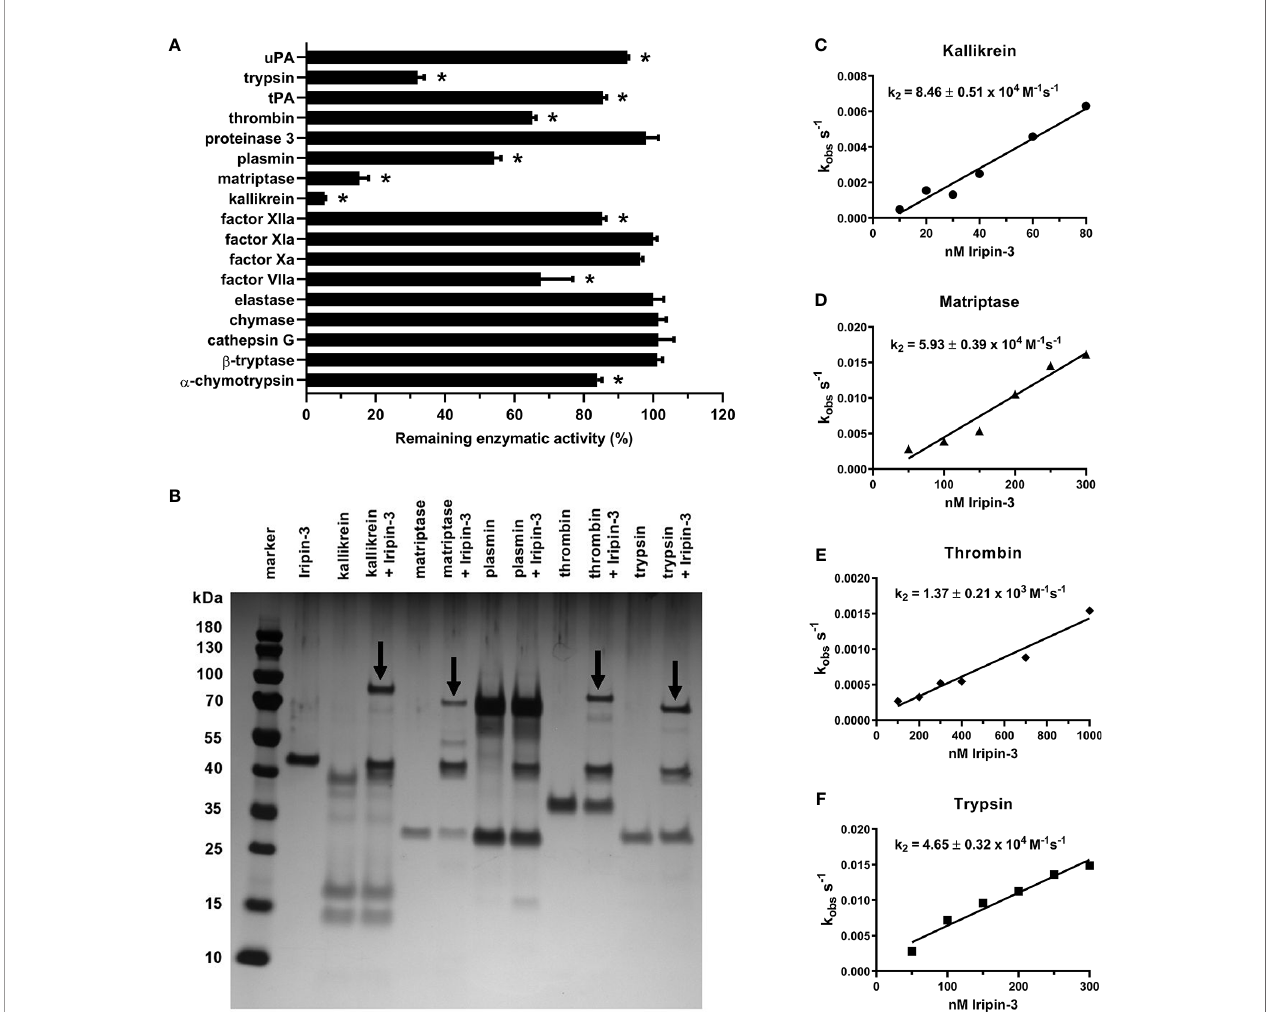
FIGURE 5 | Iripin-3 suppresses the enzymatic activities of kallikrein, matriptase, thrombin, and trypsin through the classic serpin inhibitory mechanism. (A) The residual enzymatic activities of 17 selected serine proteases in the presence of 400 nM Iripin-3. The experiment was performed in triplicate, and data are expressed as mean ± SEM. The enzymatic activities of individual proteases in the absence of Iripin-3 (control groups) were considered as 100%, and differences between control groups and Iripin-3- treated groups were analyzed by the unpaired two-tailed t -test. Enzymes labelled with an asterisk were inhibited with statistical signi fi cance (p < 0.05). (B) Formation of SDS- and heat-stable complexes between Iripin-3 and kallikrein, matriptase, plasmin, thrombin, and trypsin. Proteins were resolved on 4 to 12% NuPAGE Bis-Tris gels and visualized by silver staining. Covalent complexes between Iripin-3 and target proteases are marked with black arrows. (C – F) The apparent fi rst-order rate constant k obs was plotted against Iripin-3 concentration, and linear regression was performed to obtain the line of best fi t. The slope of the line represents the second-order rate constant k 2 for the inhibition of kallikrein (C) , matriptase (D) , thrombin (E) , and trypsin (F) by Iripin-3. For each determination, the standard error of the slope is